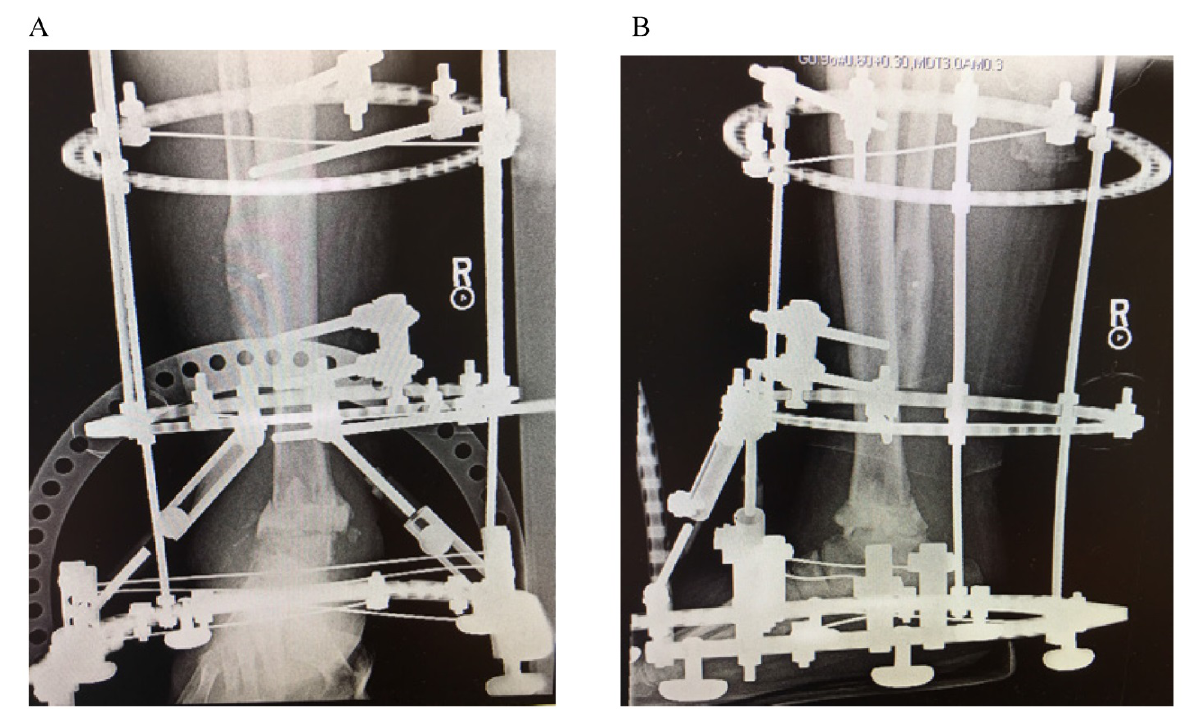
Figure 2: AP (A) and lateral (B) radiographs following removal of hardware, placement of tibiotalar antibiotic spacer and ringed external